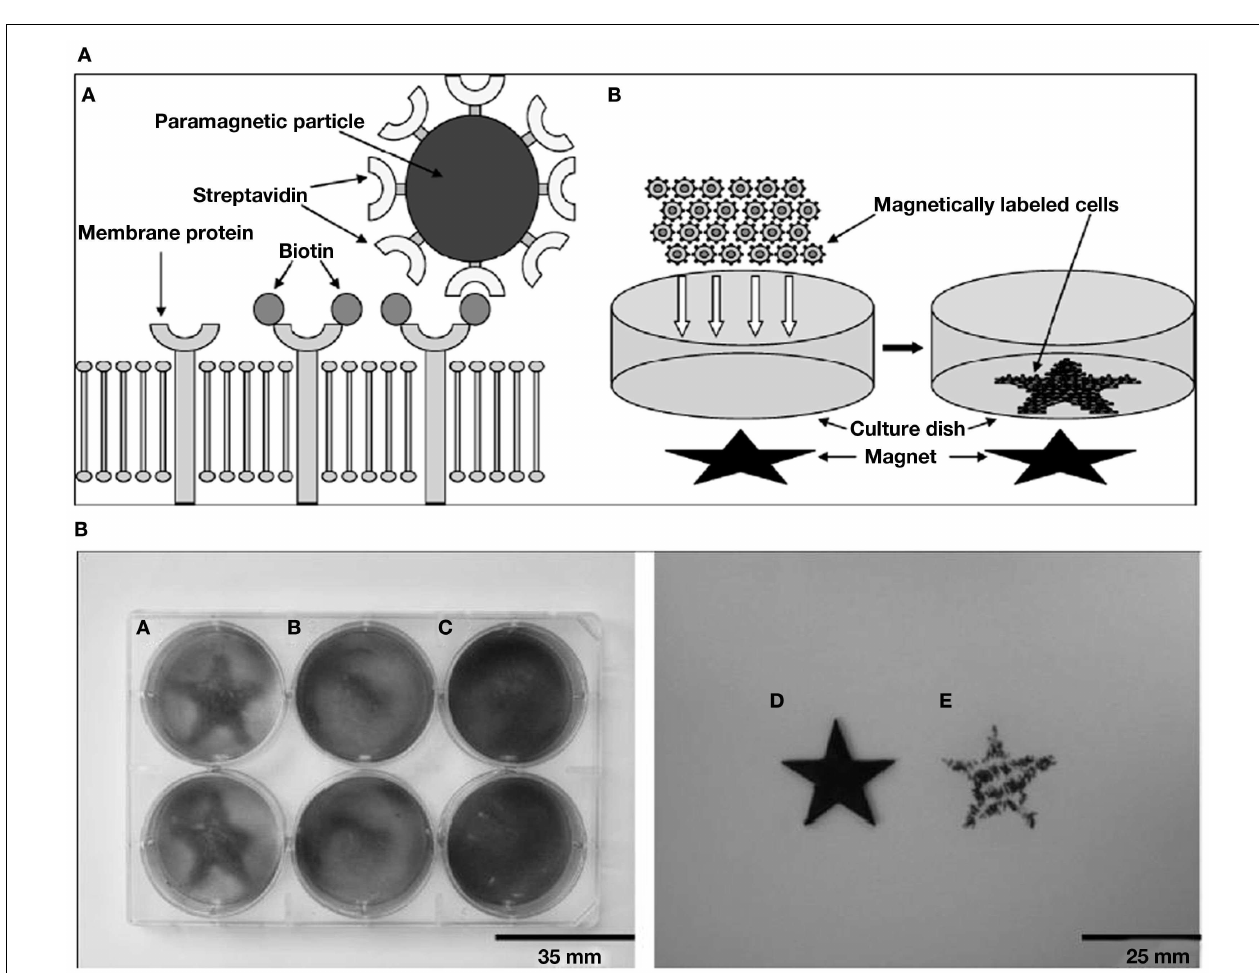
HMs were successfully patterned by the star-shaped magnetic template. B: Magnetically labeled HMs were not patterned in the absence of the magnetic template. C:The non-labeled biotinylated HMs were patterned unsuccessfully by the magnetic template. D: Original magnetic template used to pattern HMs. E: Magnetic field profile of the magnetic star template used, as visualized by using iron filings to locate magnetic field maxima. Figures and legends taken from Ho et al. (2009) with kind permission from Prof. Nigel Slater; “Copyright (2009) Royal Society of Medicine Press,